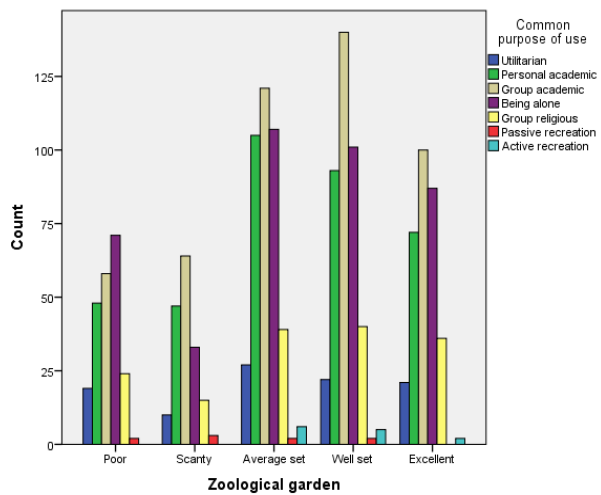
Figure 5. Influence of common purpose of use on the perception of quality of Zoological gardens in Federal Universities in South-west Nigeria .